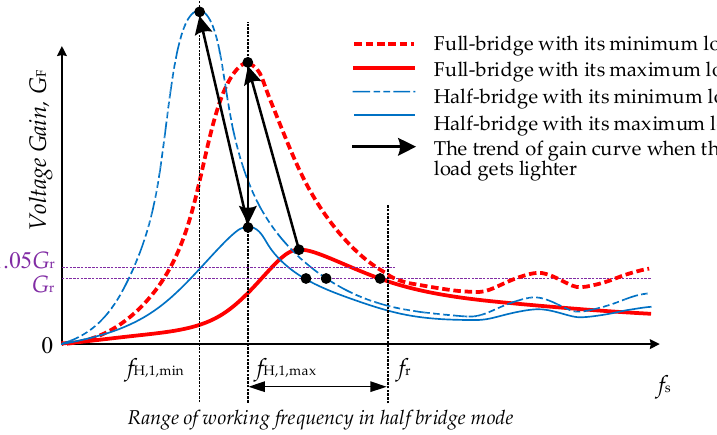
Figure 8. Voltage gain curve of CLTC converter at light load condition.